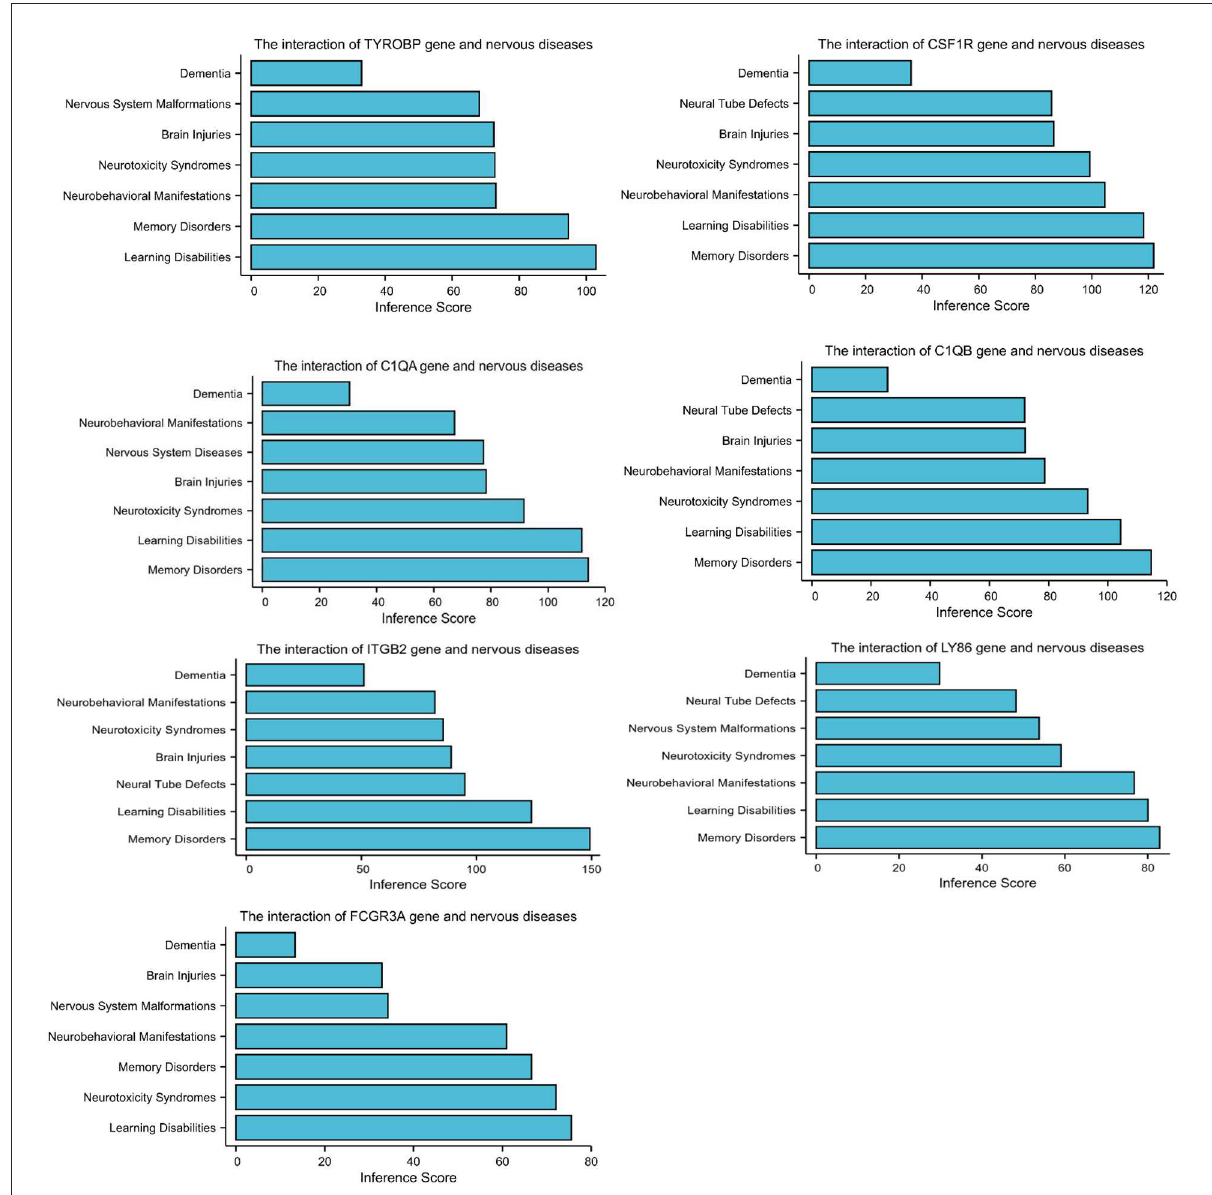
FIGURE4 Relationship to nervous system diseases related to co-expressed genes based on the CTD